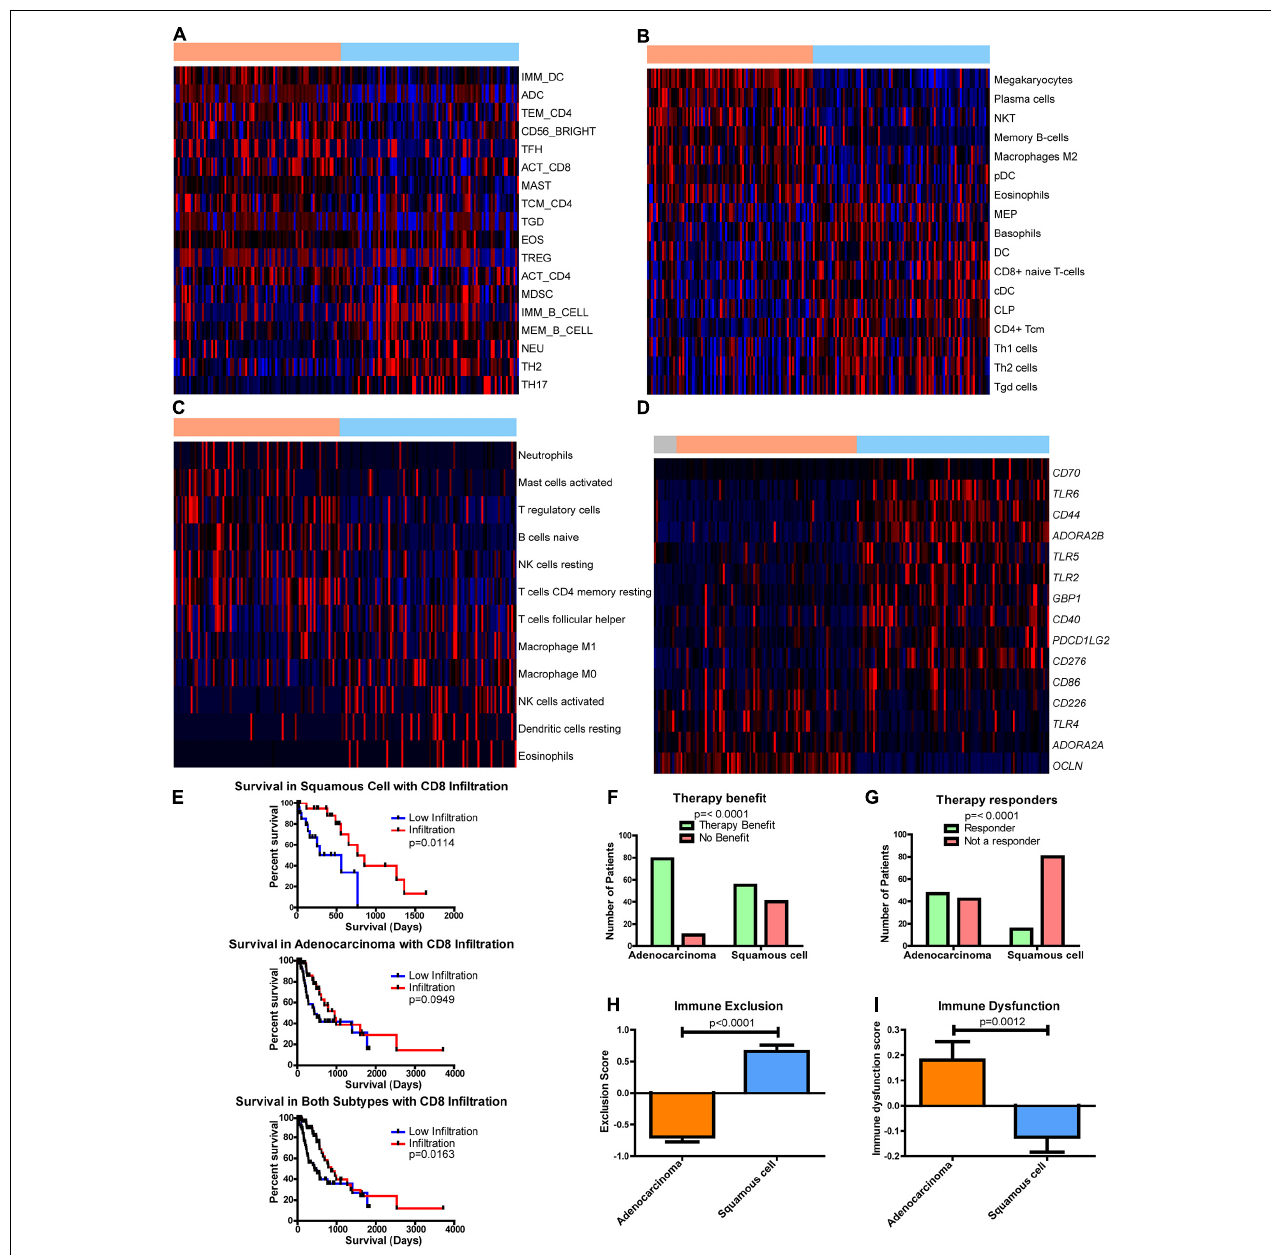
FIGURE 5 | Differences in the immune environment and predicted response to immune therapy between esophageal adenocarcinoma (EAC) and esophageal squamous cell carcinoma (ESCC) histological subtypes. Heatmap Z-scores, ranging from –2 (blue) to 2 (red), of differentially regulated ( q < 0.05) immune infiltrates according to (A) CIBERSORT, (B) xCell, (C) and TIminer utilizing the dataset of Angelova et al. (2015). (D) mRNA Z-scores of differentially expressed ( > 1.5-fold, q < 0.05) genes of potential immunotherapeutic interest between EAC and ESCC. The color bars on top indicate esophageal tissues from normal (gray), adenocarcinomas (orange), and squamous cell carcinoma (blue). (E) Kaplan–Meier survival plots for patient survival based on CIBERSORT’s immune prediction. (F–I) Shown here are predicted therapy benefit (F) , predicted therapy response (G) , immune exclusion (H) , and immune dysfunction prediction (I) according to the computational method of Tumor Immune Dysfunction and Exclusion (TIDE). Survival statistics utilized Mantel–Cox log-rank tests. Therapy prediction utilized Fisher’s exact test and a Student’s t -test for immune dysfunction, immune exclusion, and heatmaps, with the latter corrected by Benjamini–Hochberg correction for q